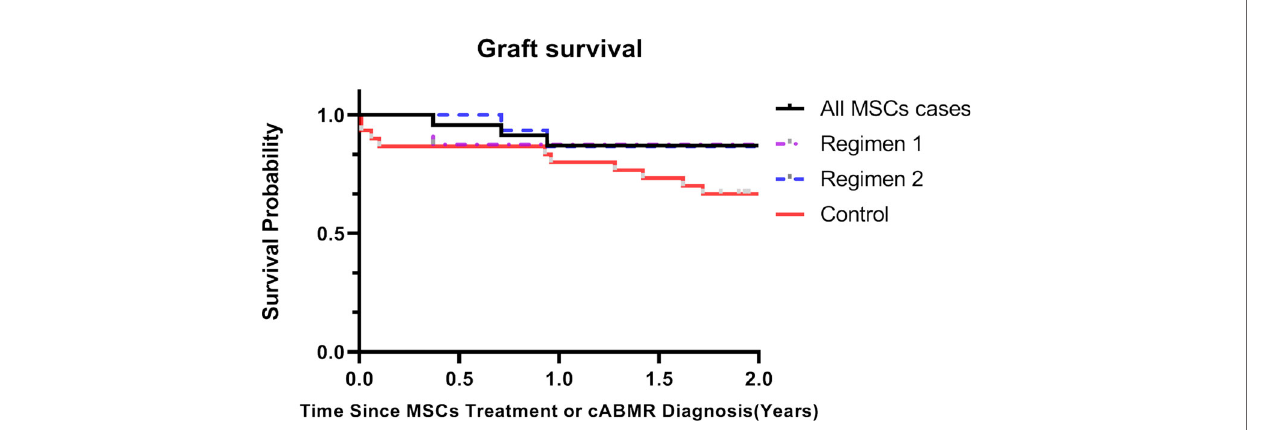
FIGURE 3 | Kaplan-Meier curves of kidney graft survival for chronic antibody-mediated rejection (cABMR) patients after BM-MSCs infusion or histological diagnosis within two years. Kaplan-Meier of graft survival of the total BM-MSCs treated (black), Regimen 1 (purple), and Regimen 2 populations (blue), and of the control group after histological diagnosis of cABMR